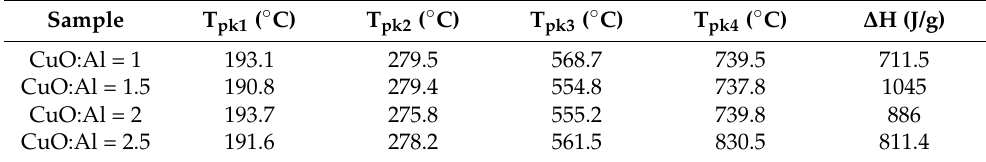
Figure 5. DSC results of Al–CuO/GO MICs with different equivalence ratios of Al and CuO. Table 1. DSC parameters of the Al–CuO/GO MICs at a heating rate of 10 °C/min.